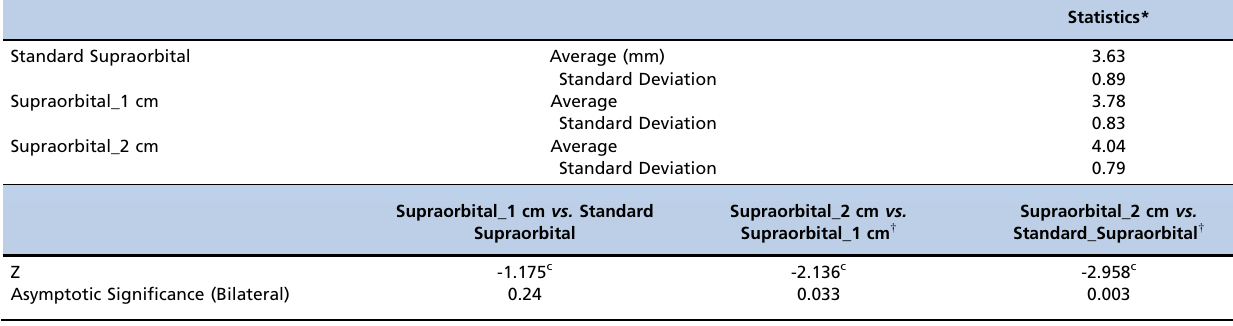
Table 2 - Supraorbital pin comparison between children 3 and 5 years of age.